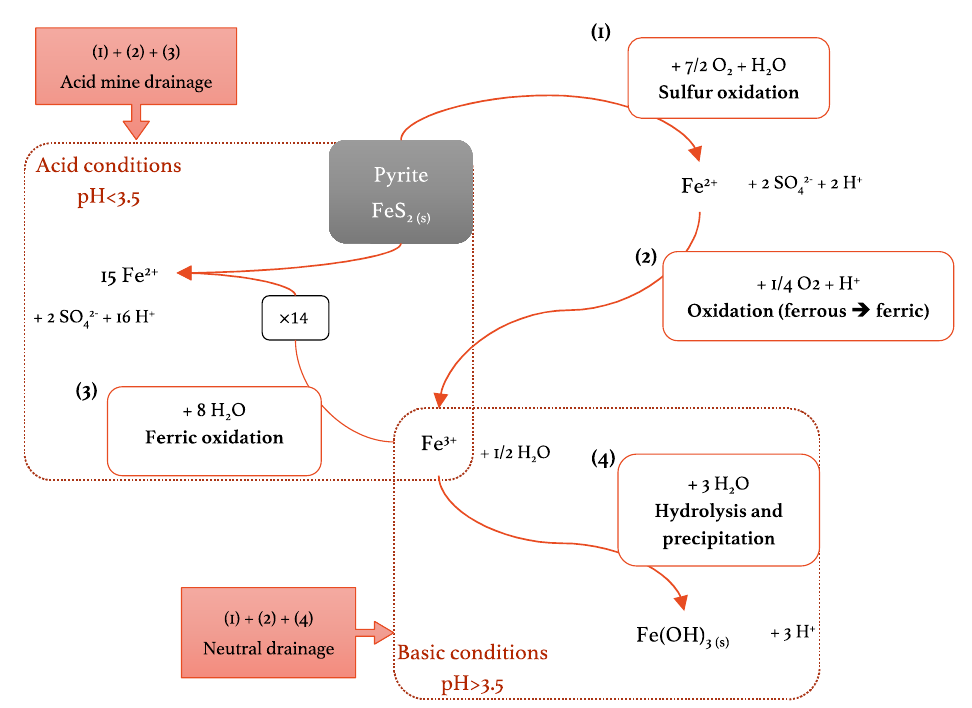
Figure 7. Processes of pyrite dissolution as a function of pH [1,9,22,39,40,51,52].